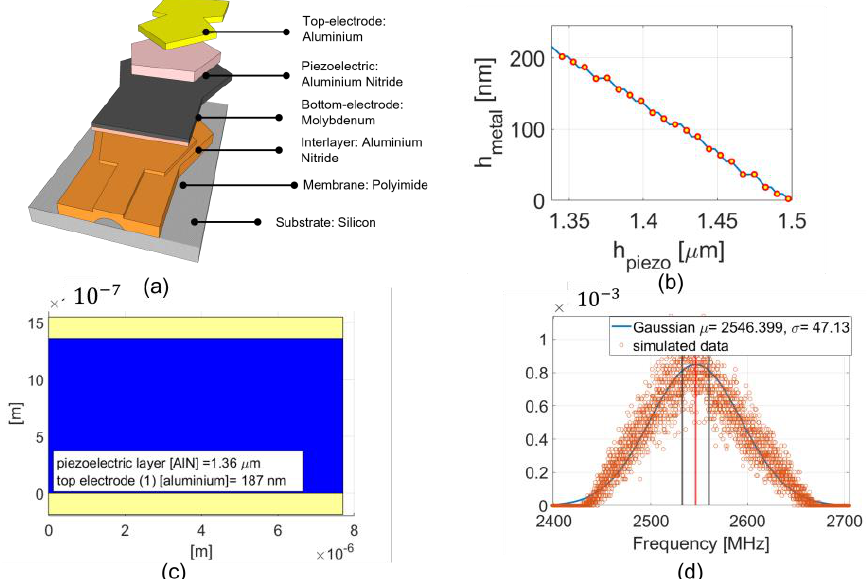
Figure 2. Resonator design using proposed innovative approach: ( a ) sketch of the resonator, ( b ) set of solutions returned by the decision algorithm, ( c ) cross-section of the selected solution, and ( d ) PDF of the resonance frequency.